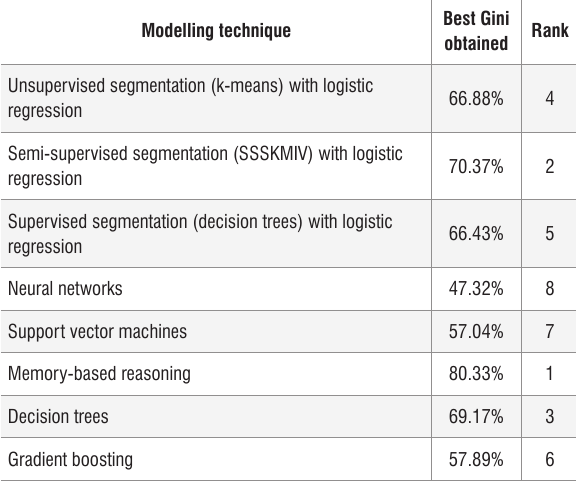
Protein tertiary structures data set: Comparison of performance Modelling technique